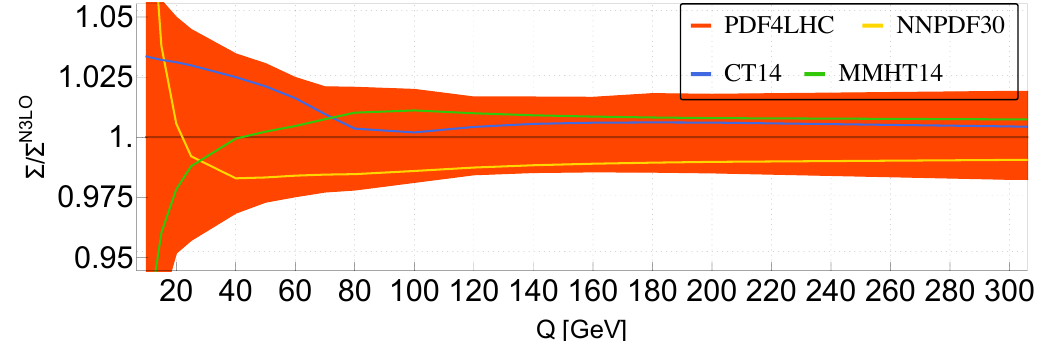
Figure 13. Dependence of the NCDY process at N 3 LO on the choice of the PDF set relative to the combined PDF4LHC15_nnlo_mc set. The red band corresponds to the δ ( PDF ) uncertainty.